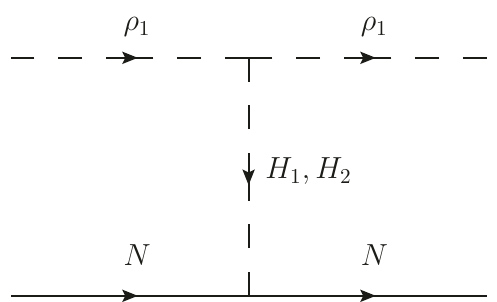
Figure 6 . Feynman diagram for the elastic scattering of (cid:26) 1 with nucleon N through the exchange of scalar bosons H 1 and H 2